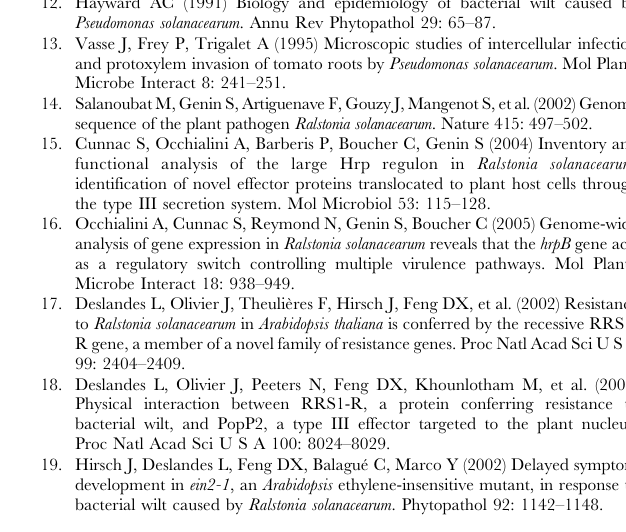
Table S2 List of genes up-regulated 5 days post inoculation in Col-5/GMI1000 and in Nd-1/ D PopP2 plants vs. Nd-1/GMI1000 plants (FDR # 0.05 and SLR $ 1) Table S3 List of genes down-regulated 5 days post inoculation in Col-5/GMI1000 and in Nd-1/ D PopP2 plants vs. Nd-1/ GMI1000 plants (FDR # 0.05 and SLR #2 1) Table S4 List of up-regulated disease genes involved in: A. the biosynthesis and signaling of ABA [21], B. genes associated with senescence [24] and C. genes induced by flg22 [25]. Table S5 List of genes specifically up-regulated 5 days post inoculation in diseased Col-5 plants (A) or in diseased Nd-1 plants (B). These genes were selected manually from the initial list of 152 (Nd-1 specific) or 56 (Col-5 specific) genes. C. List of genes down- regulated 5 days post inoculation in diseased Col-5 plants. 19 genes were manually selected from the initial list of 317. Table S6 List of primers used for Quantitative RT-PCR experiments.